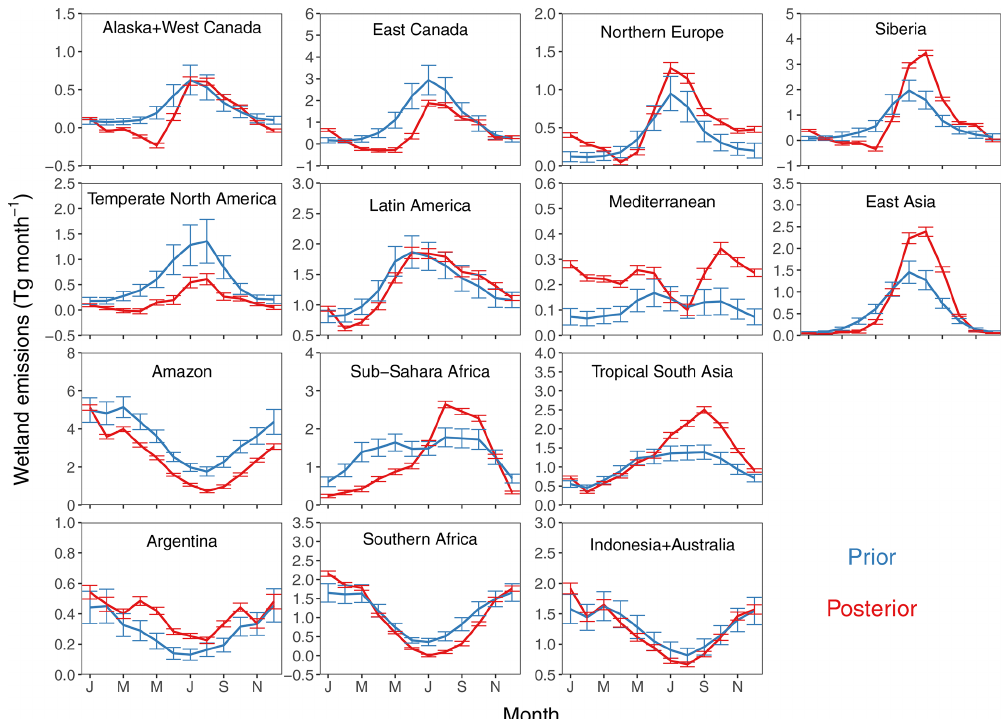
Figure 11. Seasonal variation in wetland emissions for 14 subcontinental regions (Fig. 1). Values are means for 2010–2018. The prior estimate is the mean of the WetCHARTs inventory ensemble (Bloom et al., 2017). The posterior estimate is from our inversion of GOSAT data. Vertical bars are error standard deviations. The reduction of error in the posterior estimate measures the information content provided by the GOSAT data. Scales are different between